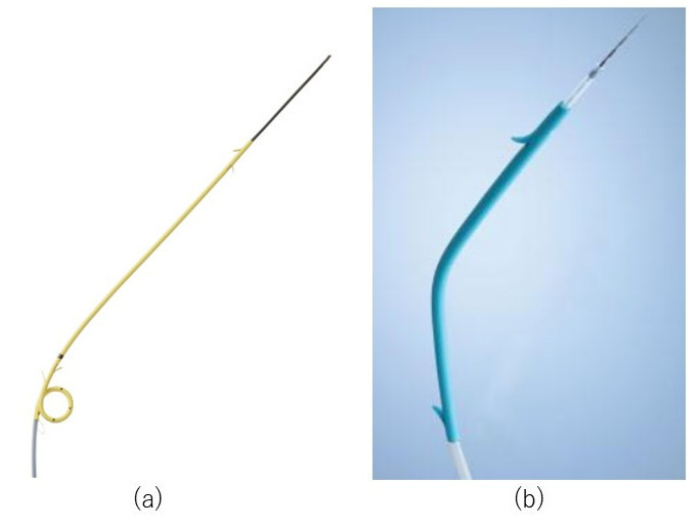
Figure 5. Plastic stent. ( a ) Through & Pass Type-IT (7-Fr, 14 cm, Gadelius Medical, Tokyo, Japan). ( b ) Quick Place V (7-Fr, Olympus Medical Systems, Tokyo, Japan).